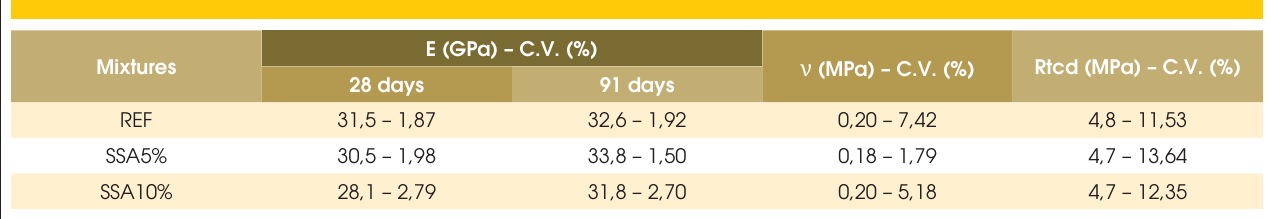
Table 5 – Elasticity modulus (E), Poisson’s index (